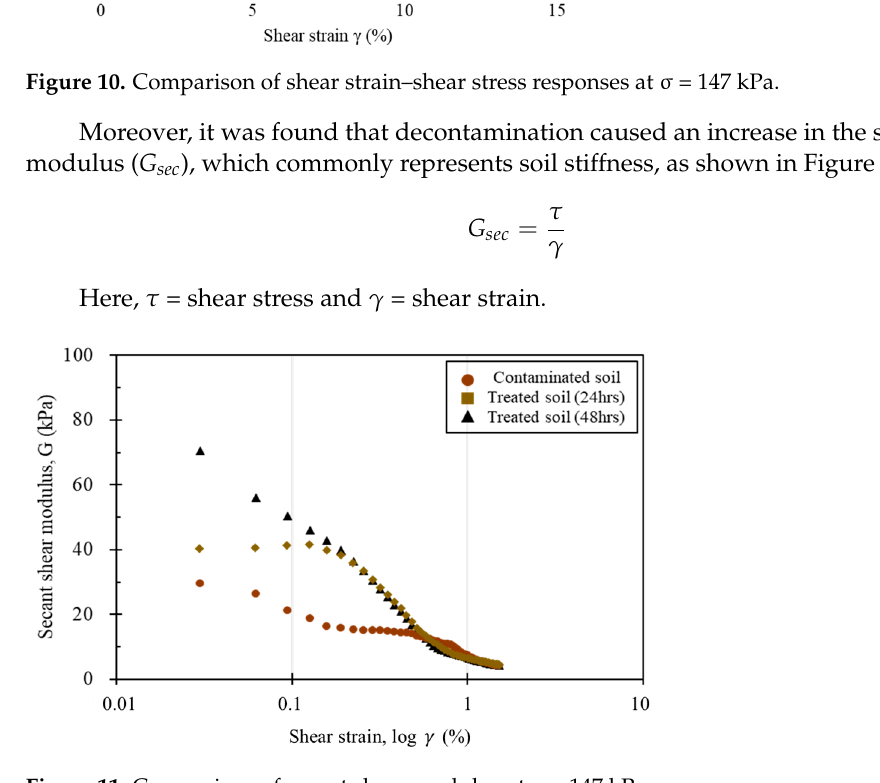
Figure 11. Comparison of secant shear modulus at σ = 147